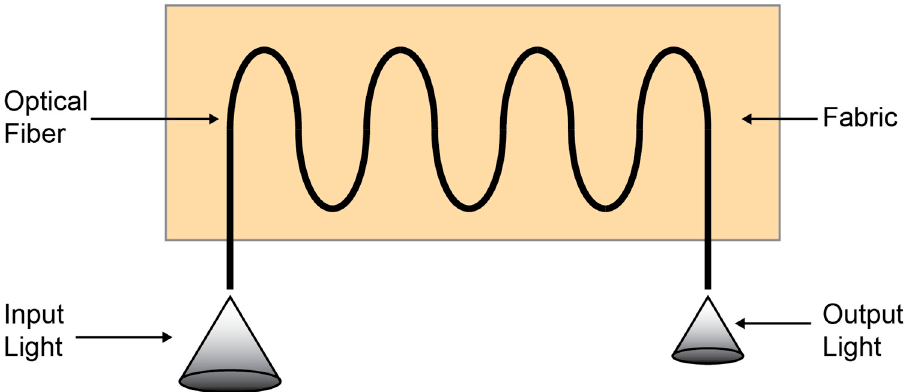
Figure 3. Schematic of a fabric with optical fibers incorporated.